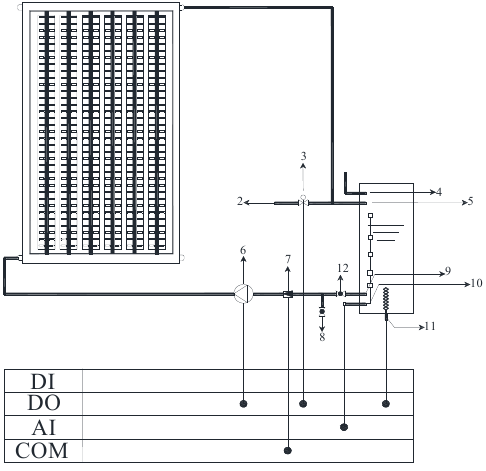
Figure 4. The energy flow of PT thermal utilization. Table 3. The components according to the Figure 4.